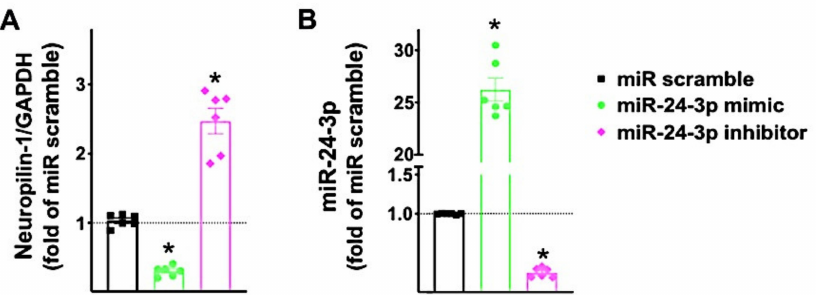
Figure 3. Neuropilin-1 expression in human brain endothelial cells is reduced by miR-24 and increased by miR-24 inhibitor. Neuropilin-1 mRNA levels ( A ) were measured in hBMECs transfected with miR-24 mimic, inhibitor, or scramble (negative control) for 48 h; miR-24 expression was assessed as well ( B ). Means ± S.E.M; * p <